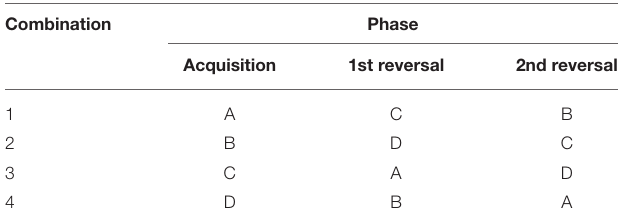
TABLE 1 | Combinations of reward configurations used for the holeboard experiment. Combination